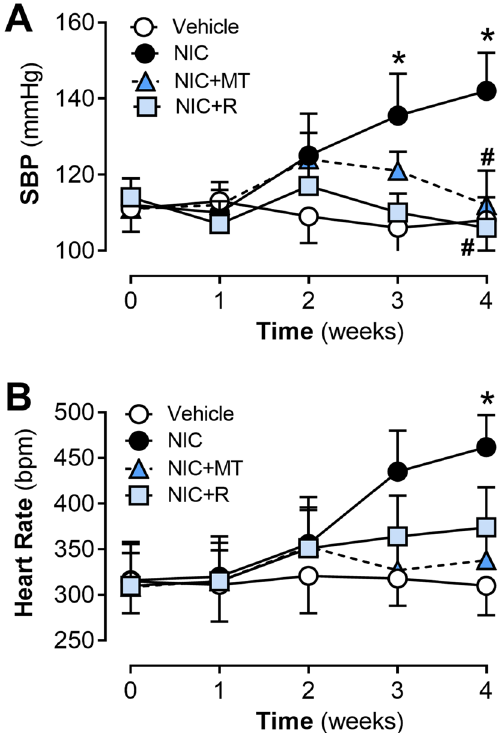
Figure 1. Time course changes in ( A ) SBP and ( B ) heart rate in rats from the vehicle, NIC, NIC + MT, and NIC + R groups over 28-days of treatment. All values are expressed as mean ± SEM for n = 13–15/group; * p < 0.05 versus vehicle group and # p < 0.05 versus NIC group using two-way ANOVA with repeated